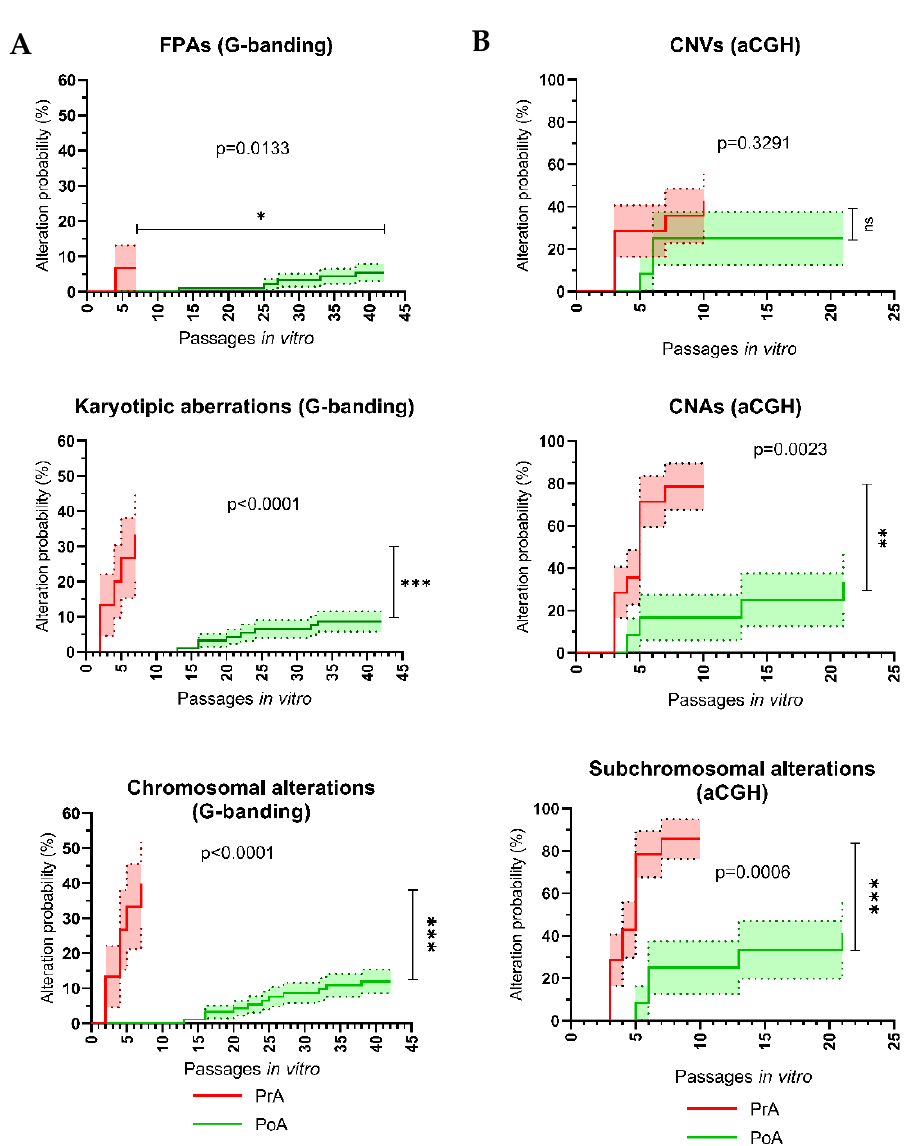
Figure 6. Adaptation to standardized cell culture conditions described by standard operating pro- cedures (SOPs) under a Quality Management System (QMS) results in improved genomic stability of cultured hPSCs. Survival analysis (Kaplan–Meier curves) of the evolution of the probability (%) of hPSCs being affected by de novo genomic alterations over time (passages in vitro) before and after adaptation to standardized cell culture conditions, using G-banding karyotyping ( A ) and Comparative Genome Hybridization array (aCGH; B ) as detection methods. For each panel, the top, middle and bottom plots show the probability of hPSCs acquiring polymorphic alterations, pathogenic alterations and total alterations, respectively. Pre-adaptation (PrA) and post-adaptation (PoA) refer to hPSCs analyzed before and after completing adaptation to the standard cell cul- ture conditions used in our laboratory, respectively. Error bars represent standard error (S.E.M.). FPA: Frequent Polymorphic Alteration; CNV: Copy Number Variation; can: Copy Number Alteration.